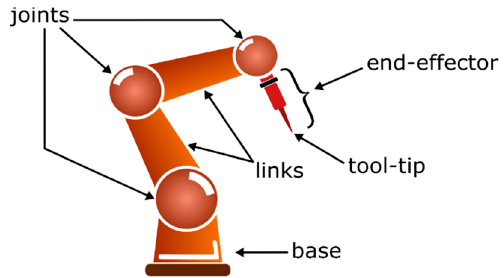
Figure 12. Robot terms.